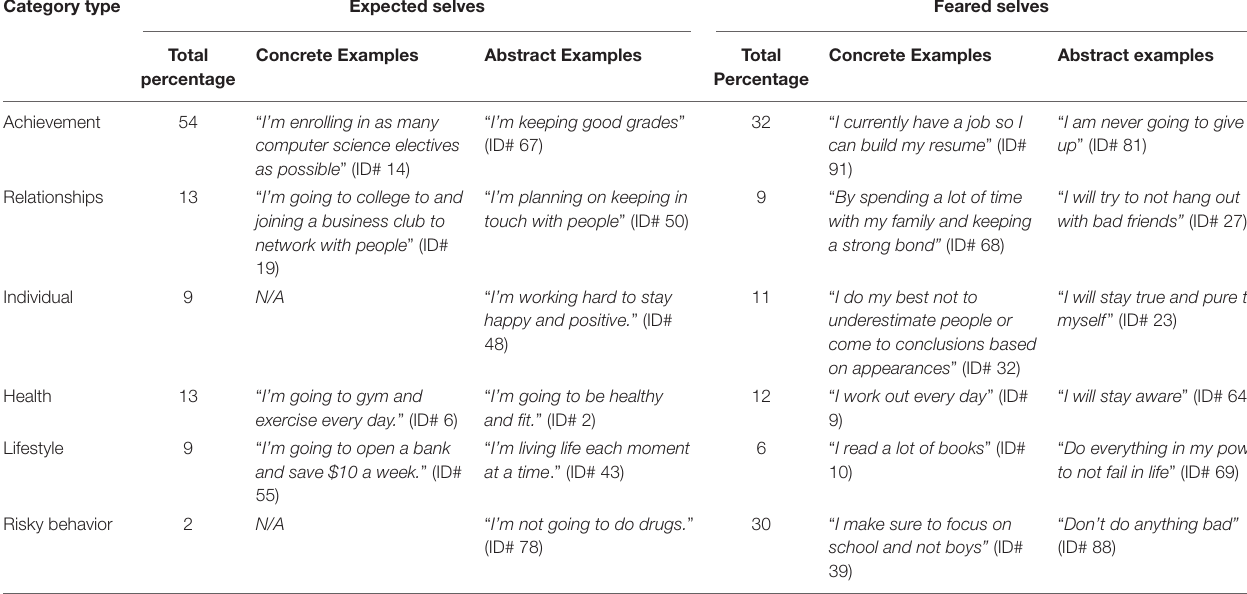
TABLE 3 | Types and examples of strategies for possible selves by